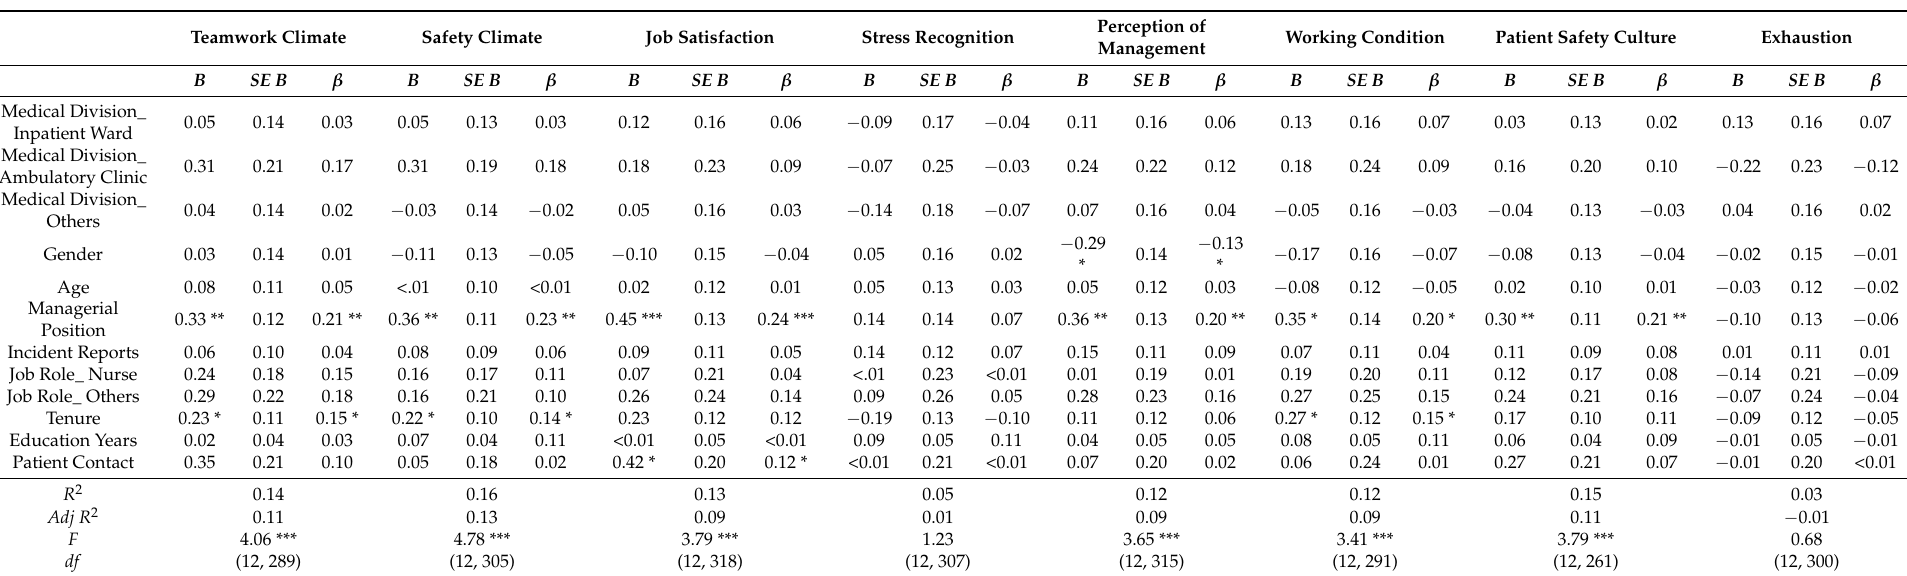
Table 8. Linear regression of background